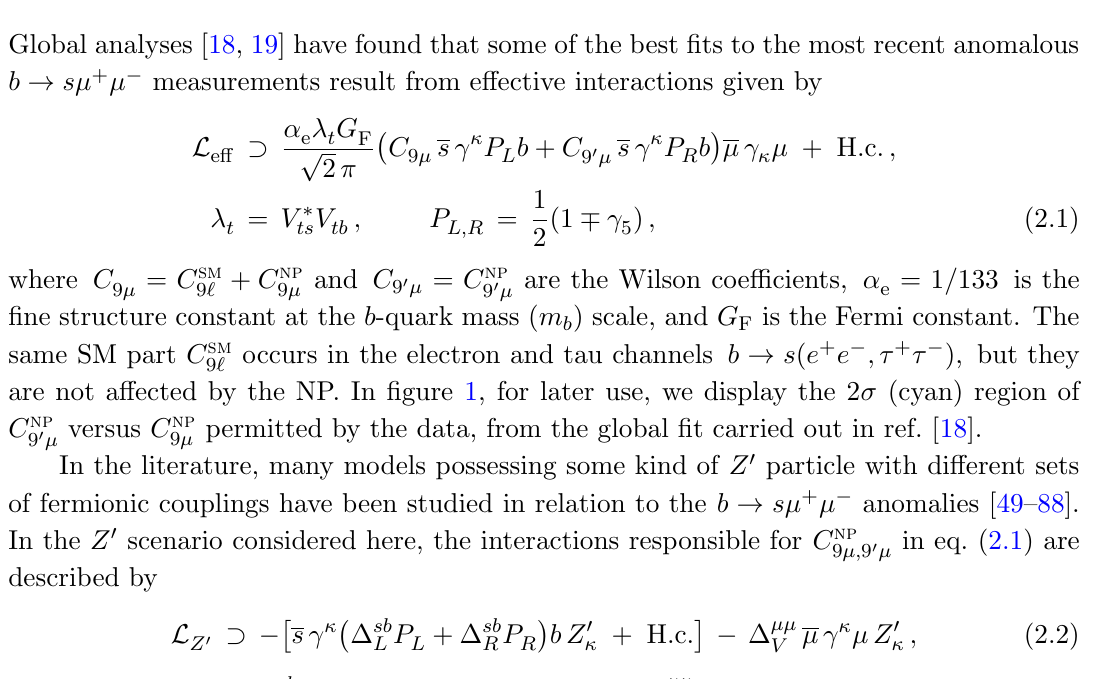
Figure 1 . Allowed 2 (cid:27) (cyan) region of C np data performed in ref.